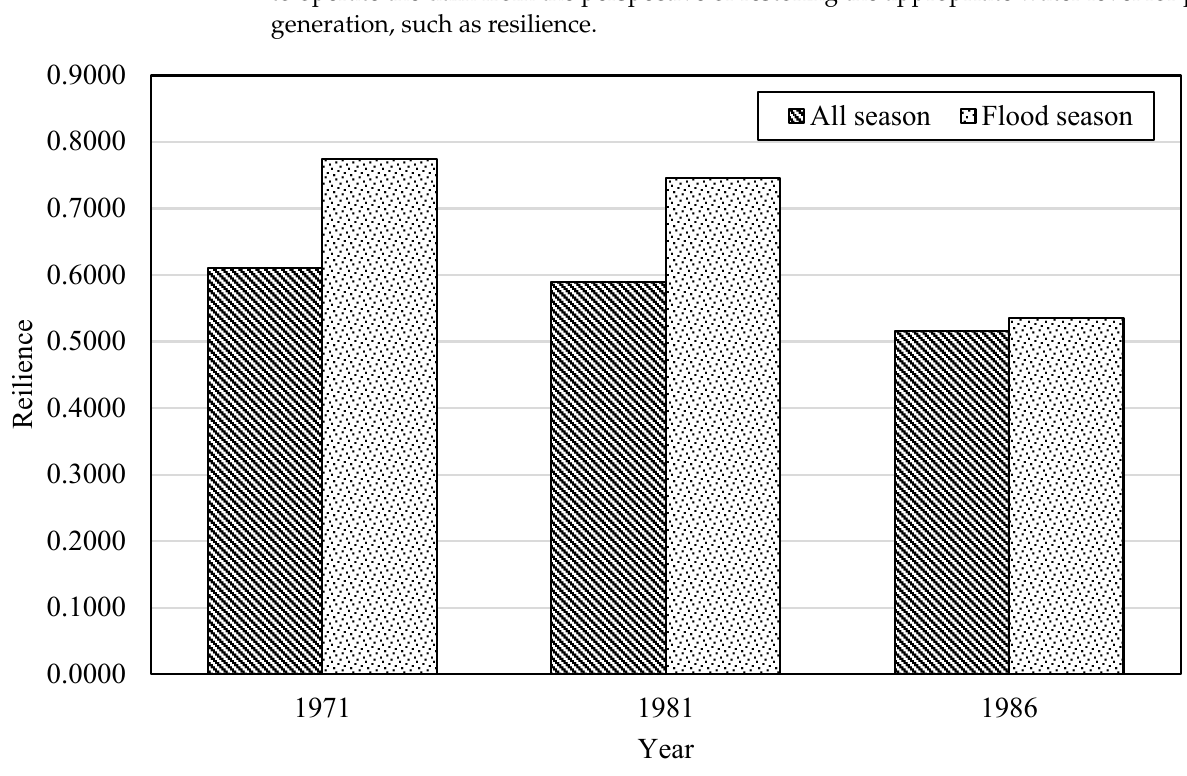
Figure 8. Comparison of resilience by year.